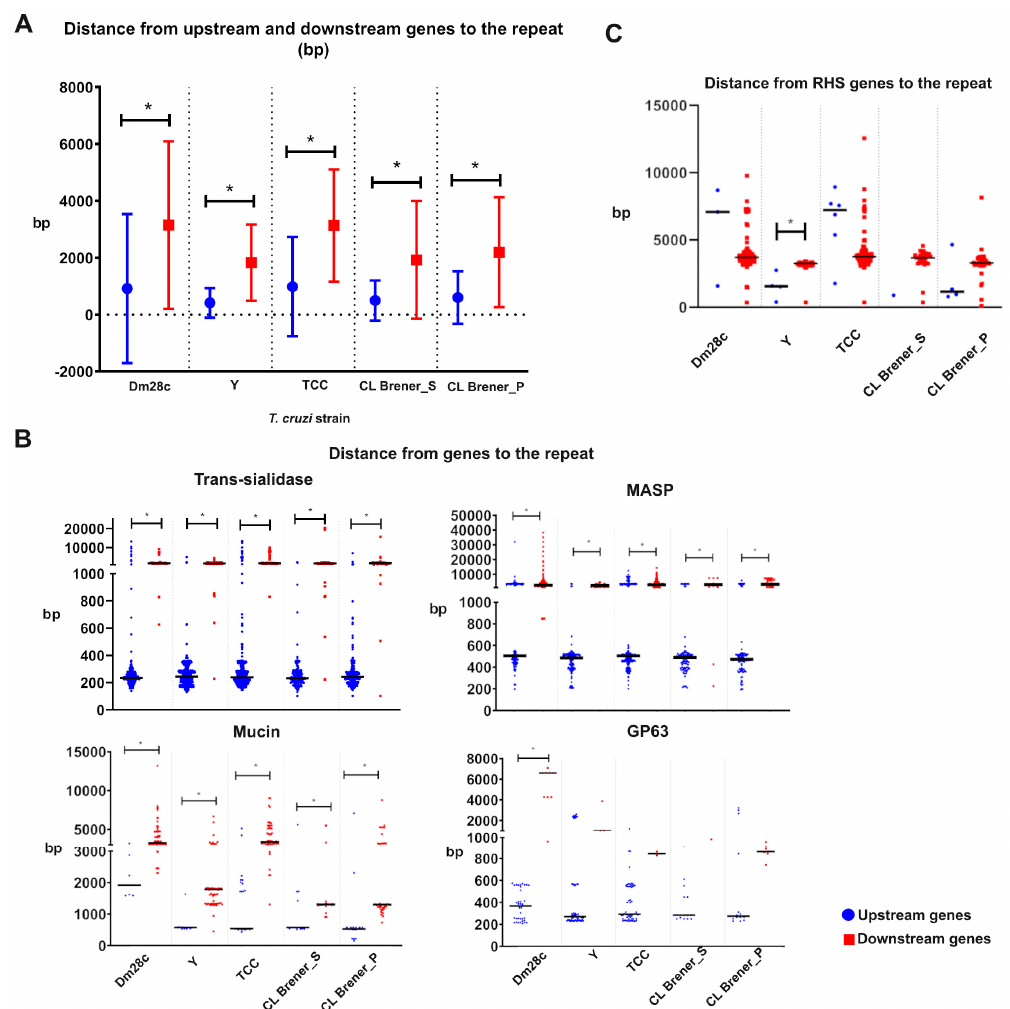
Figure 3. Distance from 241 nt repeats of upstream and downstream genes. The distances of each gene upstream (blue symbols) and downstream (red symbols) of the 241 nt repeat are plotted on the graph. Horizontal bars indicate the mean, and * indicates a p value < 0.001 from the Student’s t-test. ( A ) Distance from the 241 nt repeat to upstream genes and downstream genes on Dm28c, Y, TCC and CL Brener Esmeraldo-Like haplotype and non-Esmeraldo-Like haplotype. ( B ) Distance from 241 nt to the four main multigenic families of genes among upstream and downstream genes on Dm28c, Y, TCC and CL Brener genome sequences. ( C ) Distance from the repeat to hypothetical proteins.